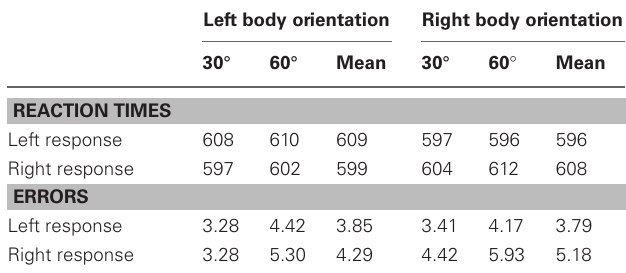
Table 1 | Average median reaction times (ms) and error rates (%) as a function of response location, body orientation, and angle of body